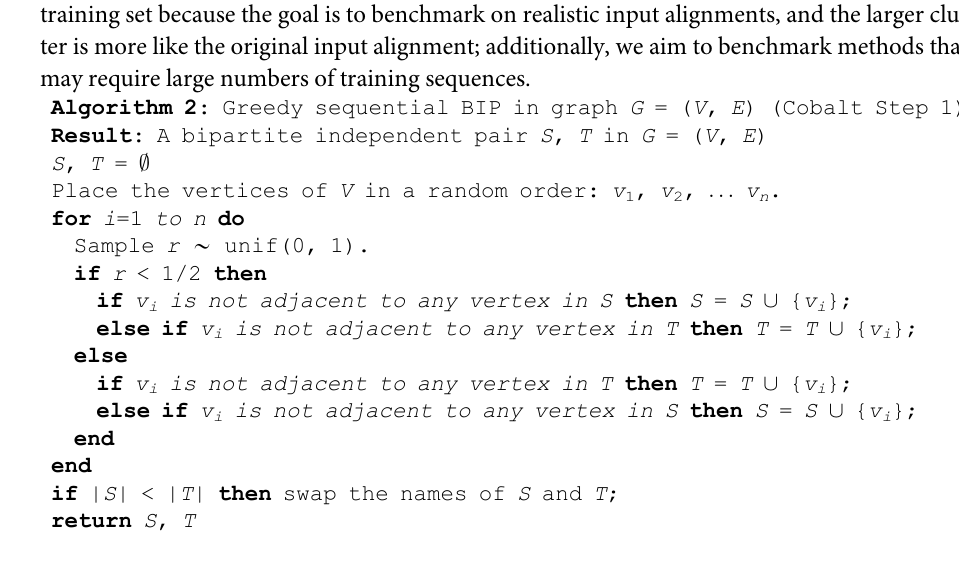
Algorithm 1 : Greedy sequential IS in graph G = ( V , E ) (Cobalt Step 2)